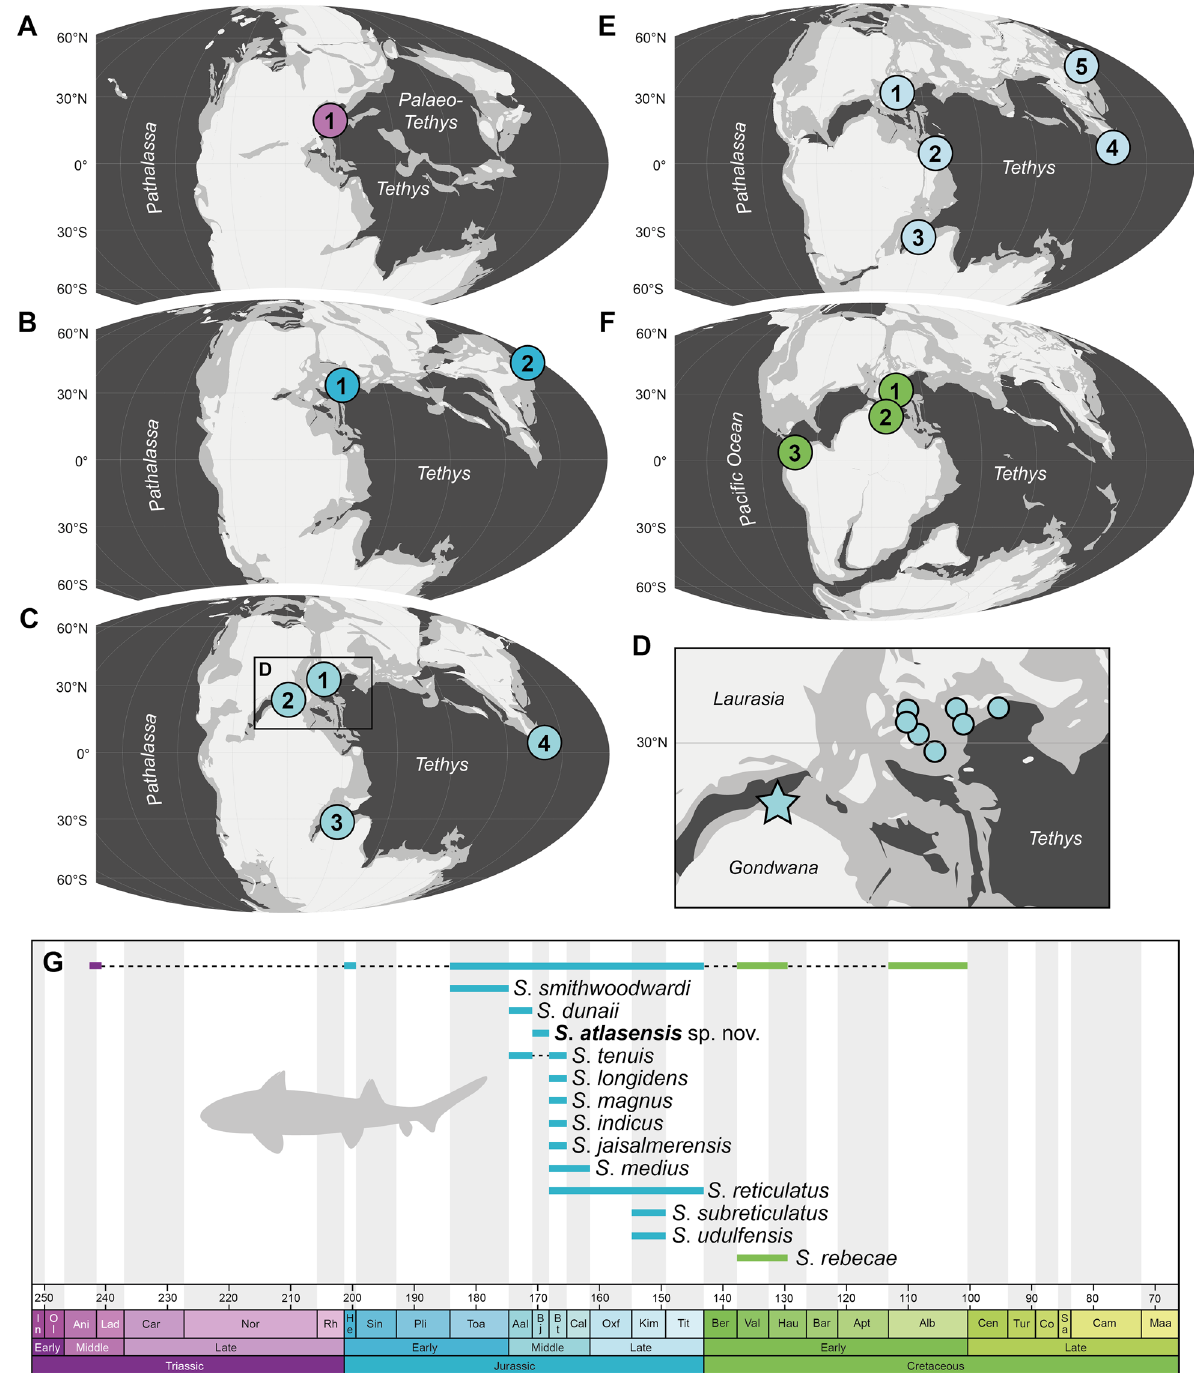
Fig. 4 Palaeogeographic maps ( A – F ) and stratigraphic chart ( G ) illustrating the spatial and temporal distribution of Strophodus (see Table 1 for more information). A Middle Triassic: 1, Switzerland. B Early Jurassic: 1, Switzerland and Italy; 2, Japan. C Middle Jurassic: 1, Europe; 2, Morocco; 3, India; 4, Thailand. D Western Tethys region during the Middle Jurassic depicting the reported occurrences of Strophodus from Europe (indicated by dots) and the type locality of Strophodus atlasensis sp. nov. near Talsint, Morocco (indicated by a star). E Late Jurassic: 1, Europe; 2, Lebanon; 3, India and Madagascar; 4, Thailand; 5, Japan. F Early Cretaceous: 1, France and Switzerland; 2, Tunisia; 3,